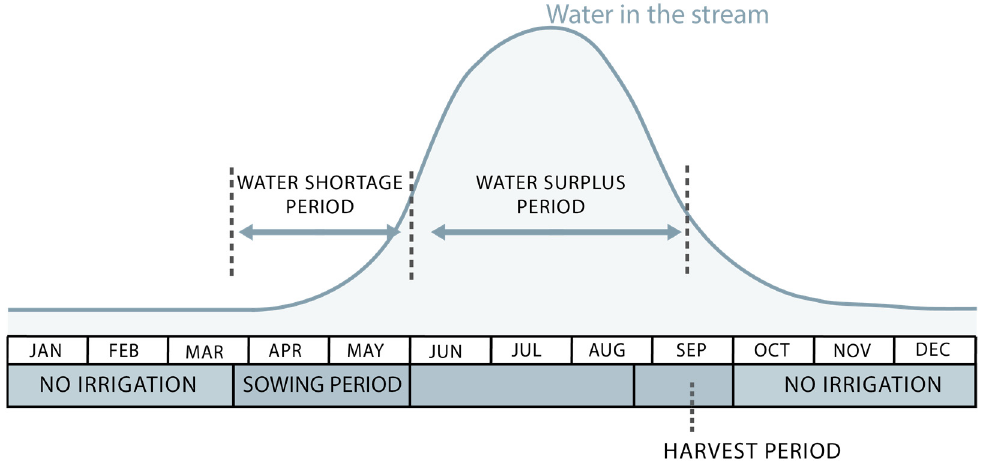
Figure 4. Seasonal variation in the availability of meltwater in glacial streams (conceptual graph. Adapted from [57].